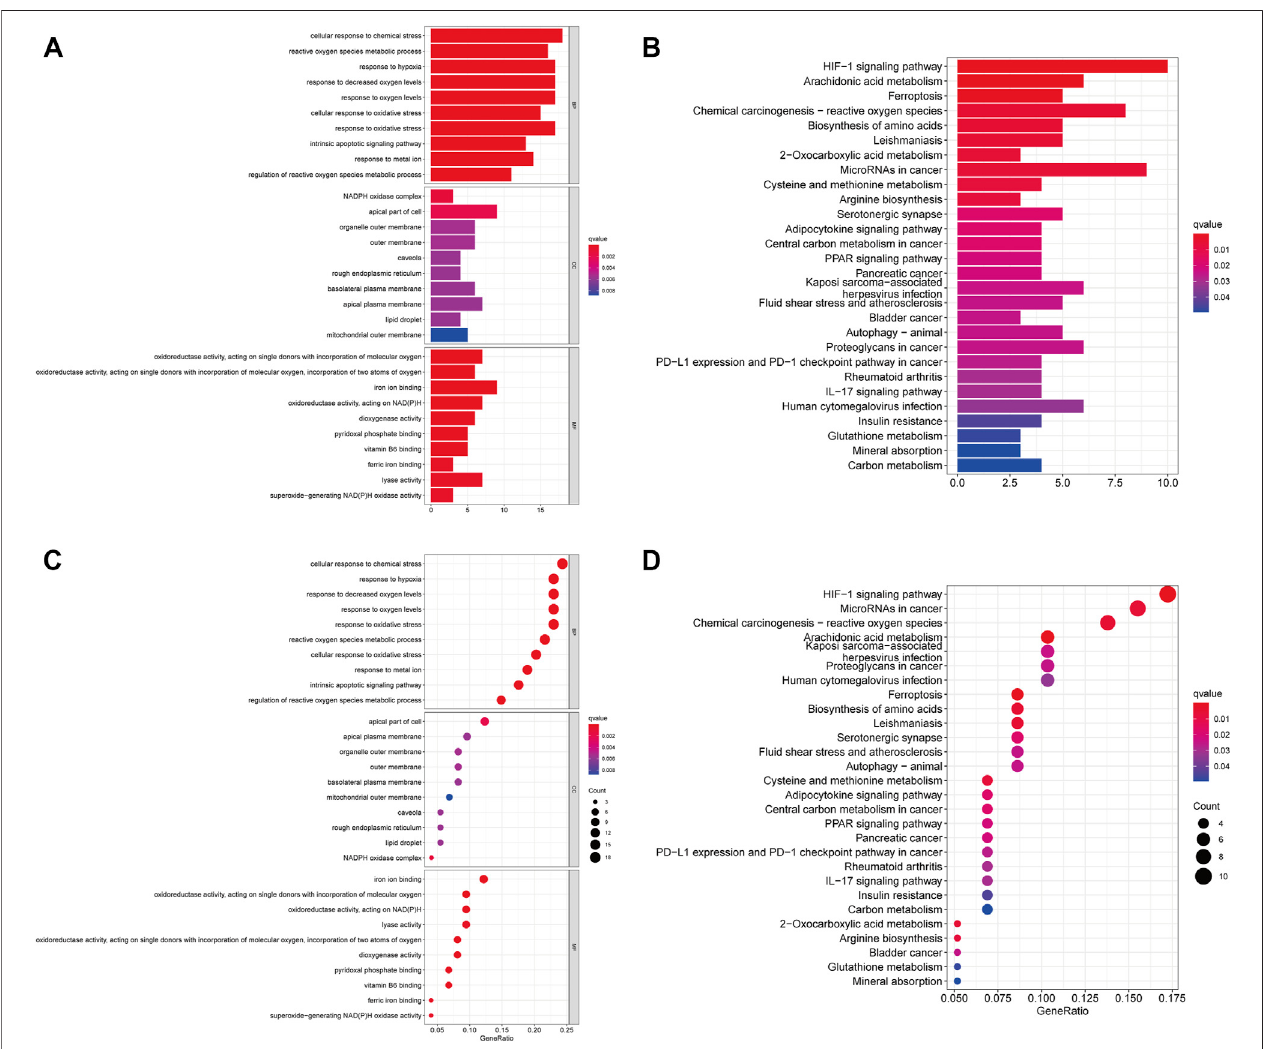
FIGURE 1 | Functional Enrichment Analysis of FRGs in ccRCC patients. (A) The bar plot of GO functional enrichment analysis of FRGs in ccRCC patients. (B) The bubblediagramofGOfunctionalenrichmentanalysisofFRGsinccRCCpatients. (C) ThebarplotofKEGGpathwayenrichmentanalysisofFRGsinccRCCpatients. (D) The bubble diagram of KEGG pathway enrichment analysis of FRGs in ccRCC patients ( p <